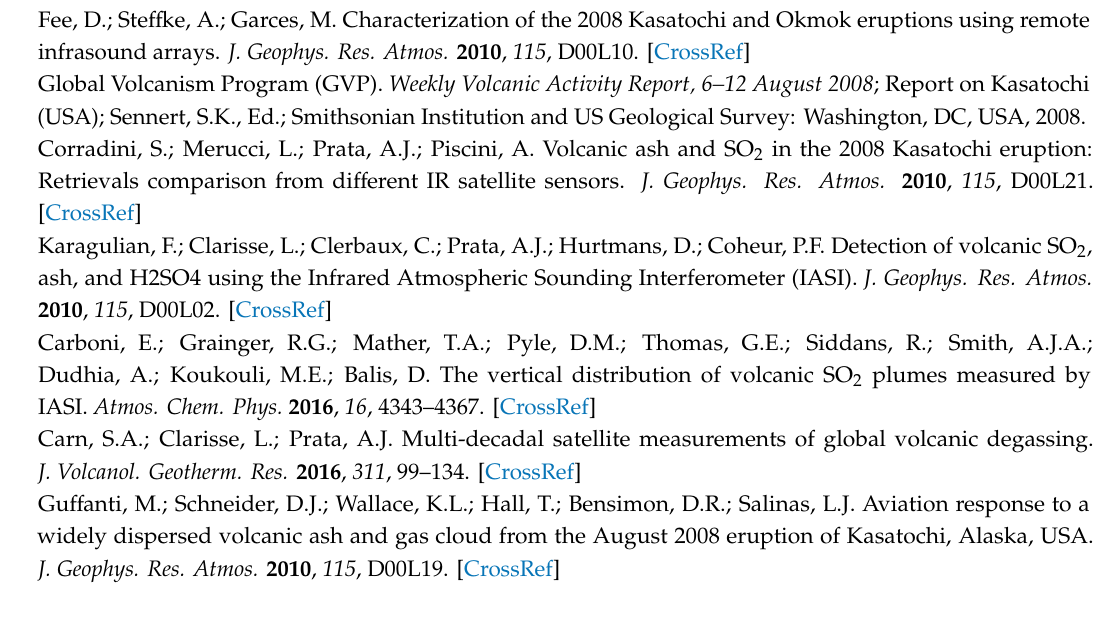
Figure S1: Bending angle anomaly comparison between climatology calculated with two di ff erent methodologies, Figure S2: CALIOP backscatter and bending angle anomaly for collocation number 5, Figure S3: CALIOP backscatter and bending angle anomaly for collocation number 22, Figure S4: CALIOP backscatter and bending angle anomaly for collocation number 23. Table S1: Altitude estimation table, Table S2: Collocations date and time, Table S3: Error